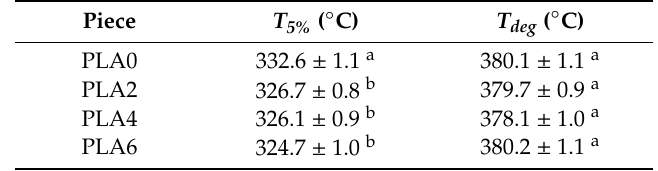
Table 4. Main thermal parameters of the injection-molded polylactide (PLA) pieces subjected to different reprocessing cycles in terms of onset temperature of degradation (T 5% ) and degradation temperature (T deg ).